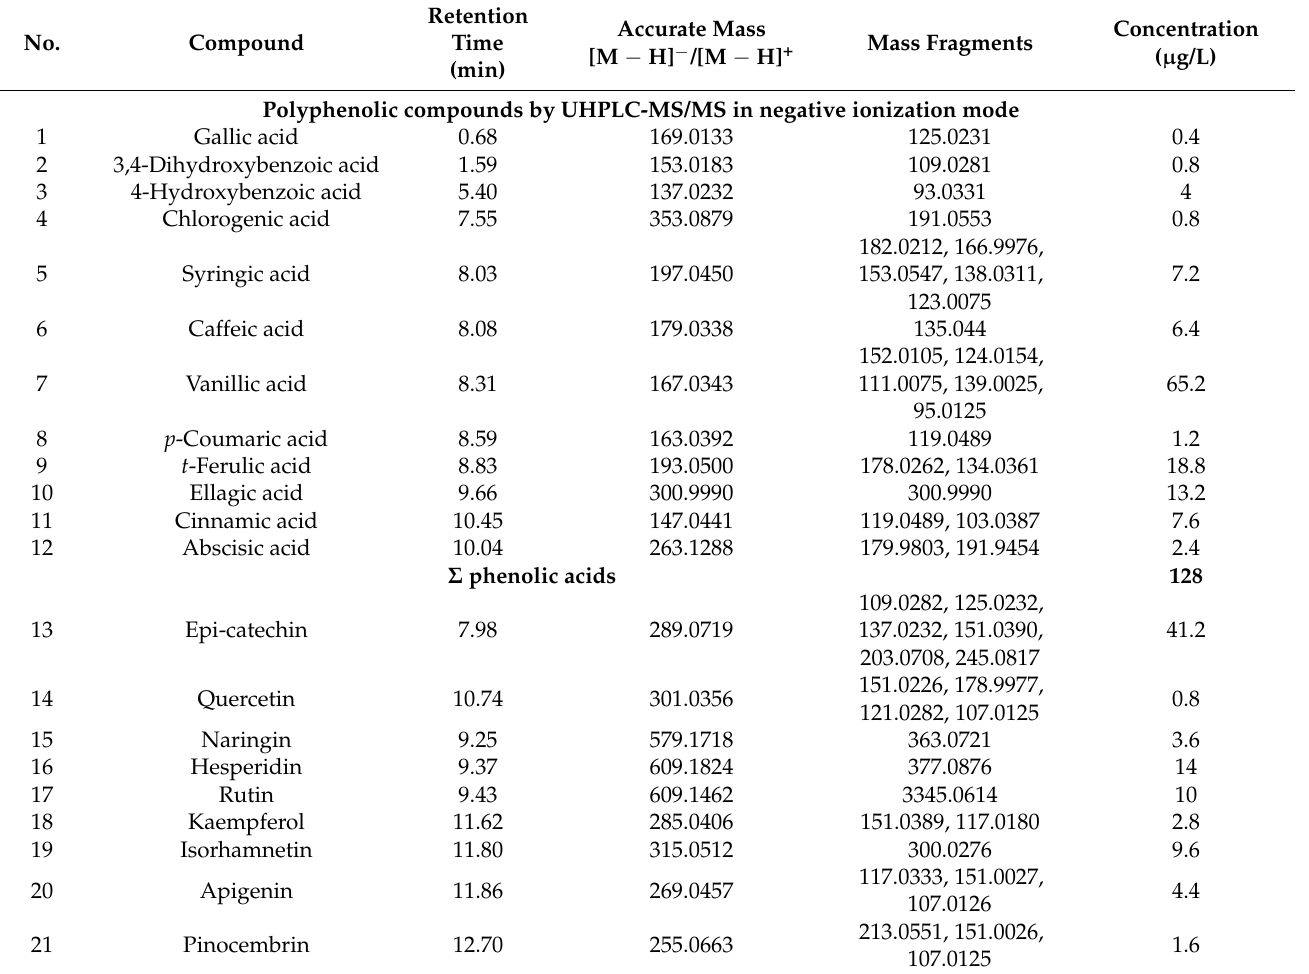
Table 2. Identification and quantitative data regarding the bioactive compounds in the A. sativum liquid extract.